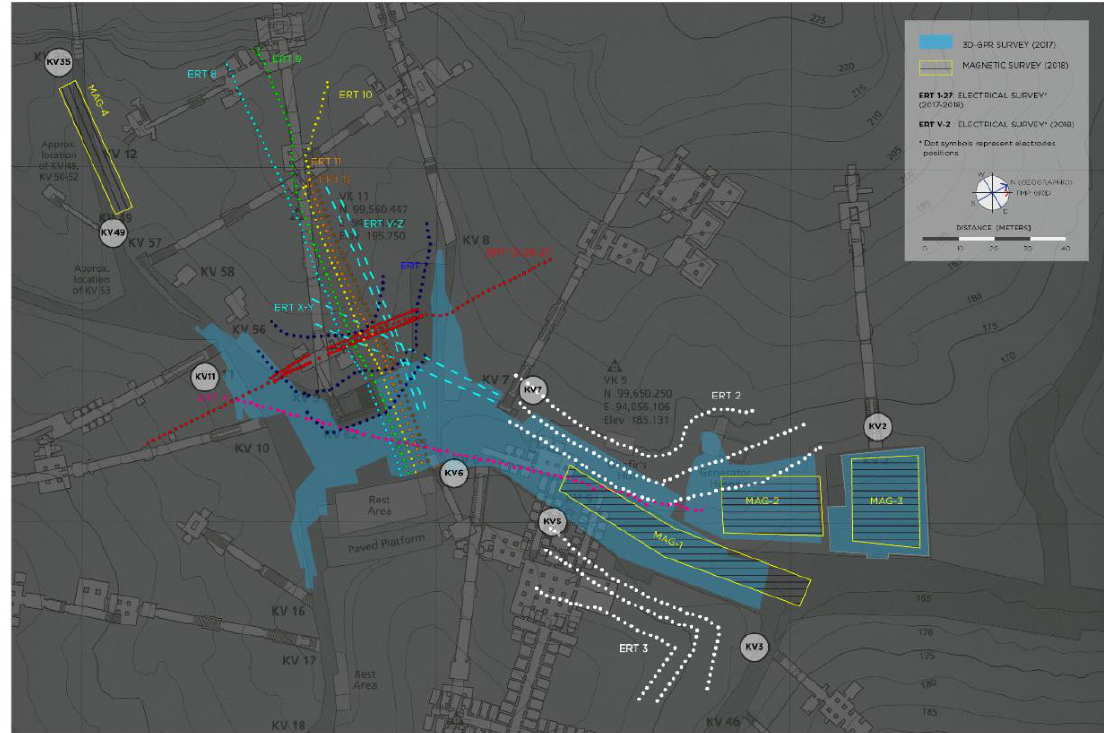
Figure 8. Map of the geophysical surveys performed in the area which contribute to the presented results. The di ff erent colored lines refer to the di ff erent Electrical Resistivity Tomography (ERT) results. The different colored lines refer to the different Electrical Resistivity Tomography (ERT) surveys surveys executed.